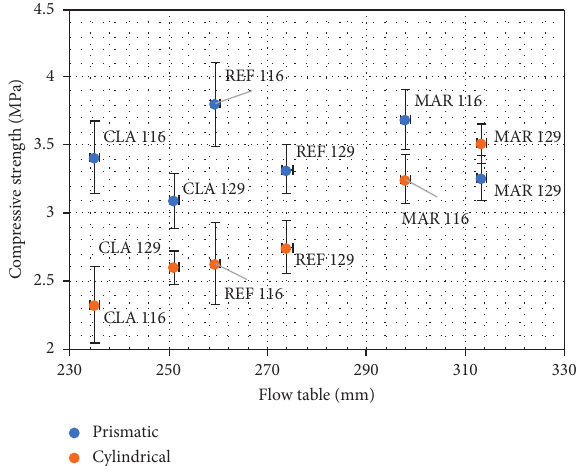
Figure 4: Results of compressive strength to prismatic and cy- lindrical geometries and of workability for the studied